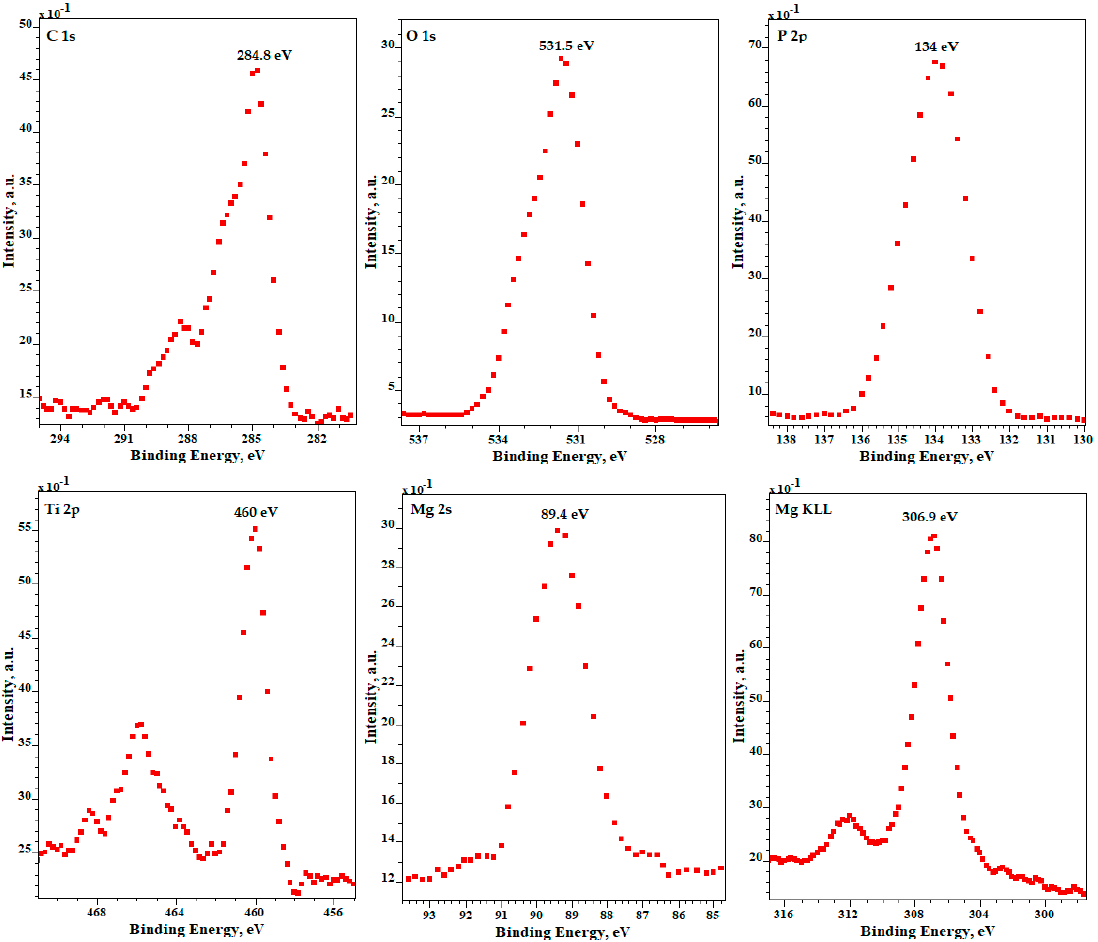
Figure 6. XPS results for samples after PEO processing obtained in electrolyte composed of Mg(NO 3 ) 2 ·6H 2 O in H 3 PO 4 at a concentration of 600 g/L at a voltage of 450 ± 46 V, with a pulsation frequency of 300 Hz.